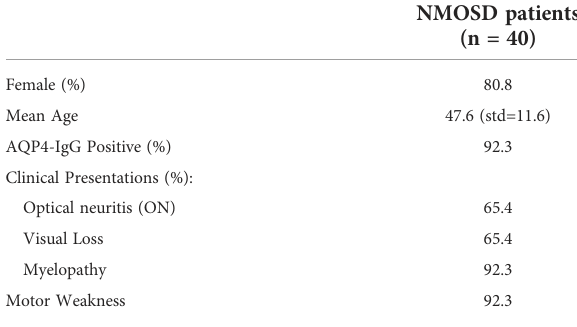
TABLE 1 Clinical and demographic characteristics of NMOSD